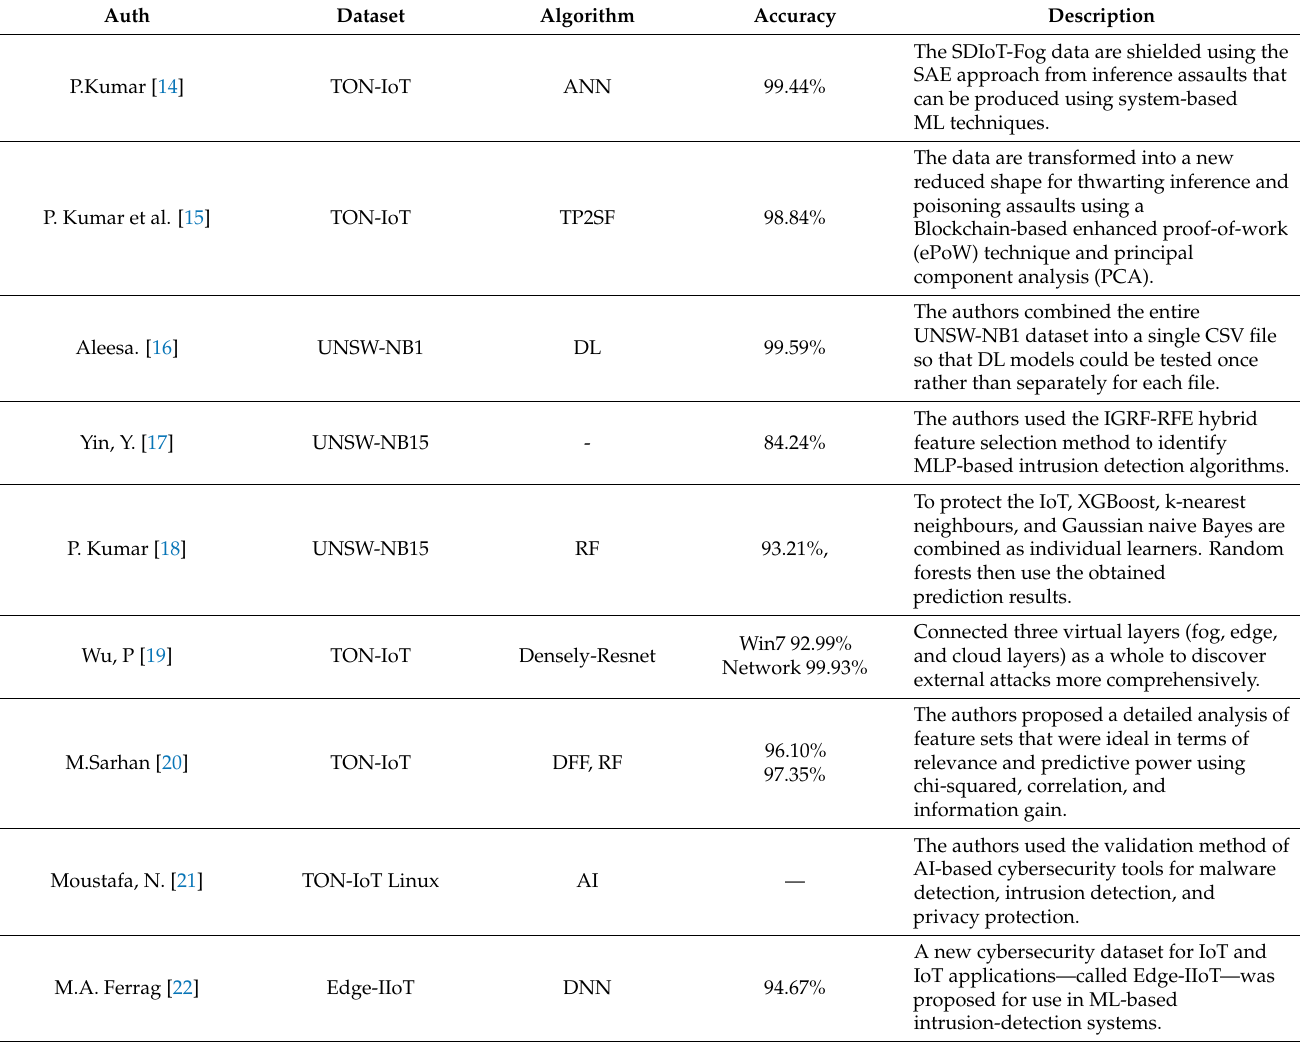
Table 1. Summary of previous